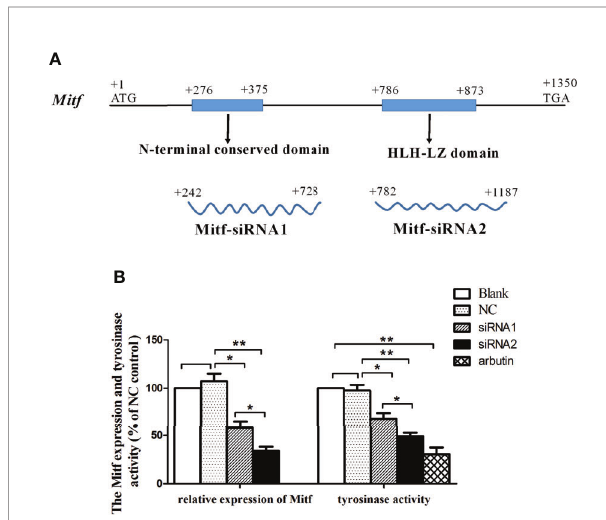
FIGURE 4 | The effect of Mitf silencing on Tyr expression and tyrosinase activity. (A) The position and length of siRNA1 and siRNA2 (B) The PpMitf expression and tyrosinase activity analysis. The samples were from blank group, NC group (GFP-siRNA), PpMitf -siRNA1 and PpMitf -siRNA2 group. The b -actin of P. penguin was used as an internal control in qRT-PCR. The arbutin group was used as positive control in tyrosinase activity analysis. The data were represented as mean ± SD ( N = 5). * P < 0.05; ** P < 0.01; No signal means no